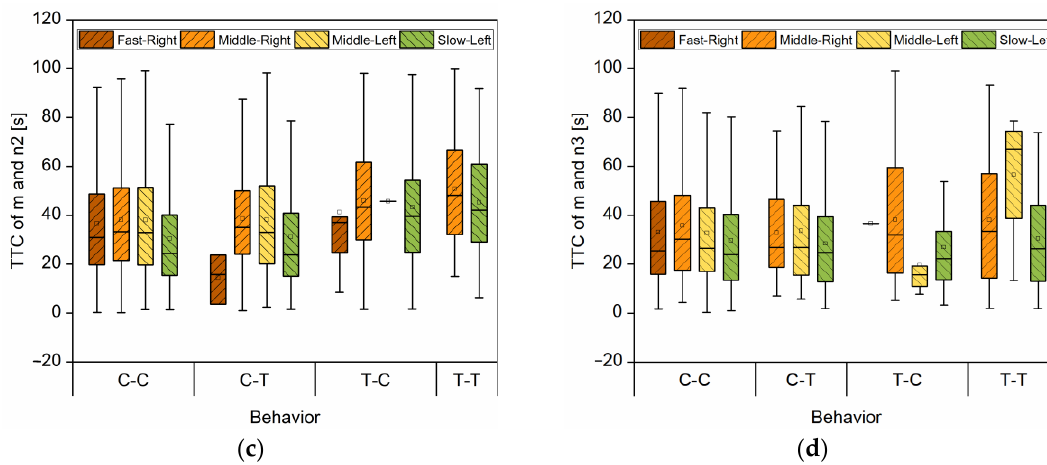
Figure 8. ( a ) Probability distribution of TTC; ( b ) TTC between m and n1; ( c ) TTC between m and n2; ( d ) TTC between m and n3.